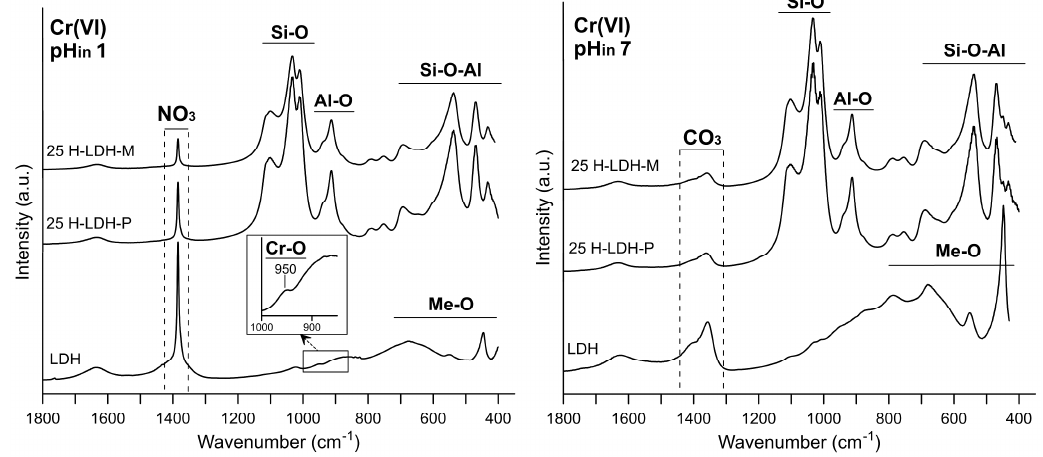
Figure 8. FTIR spectra of selected samples after reaction with Cr(VI).